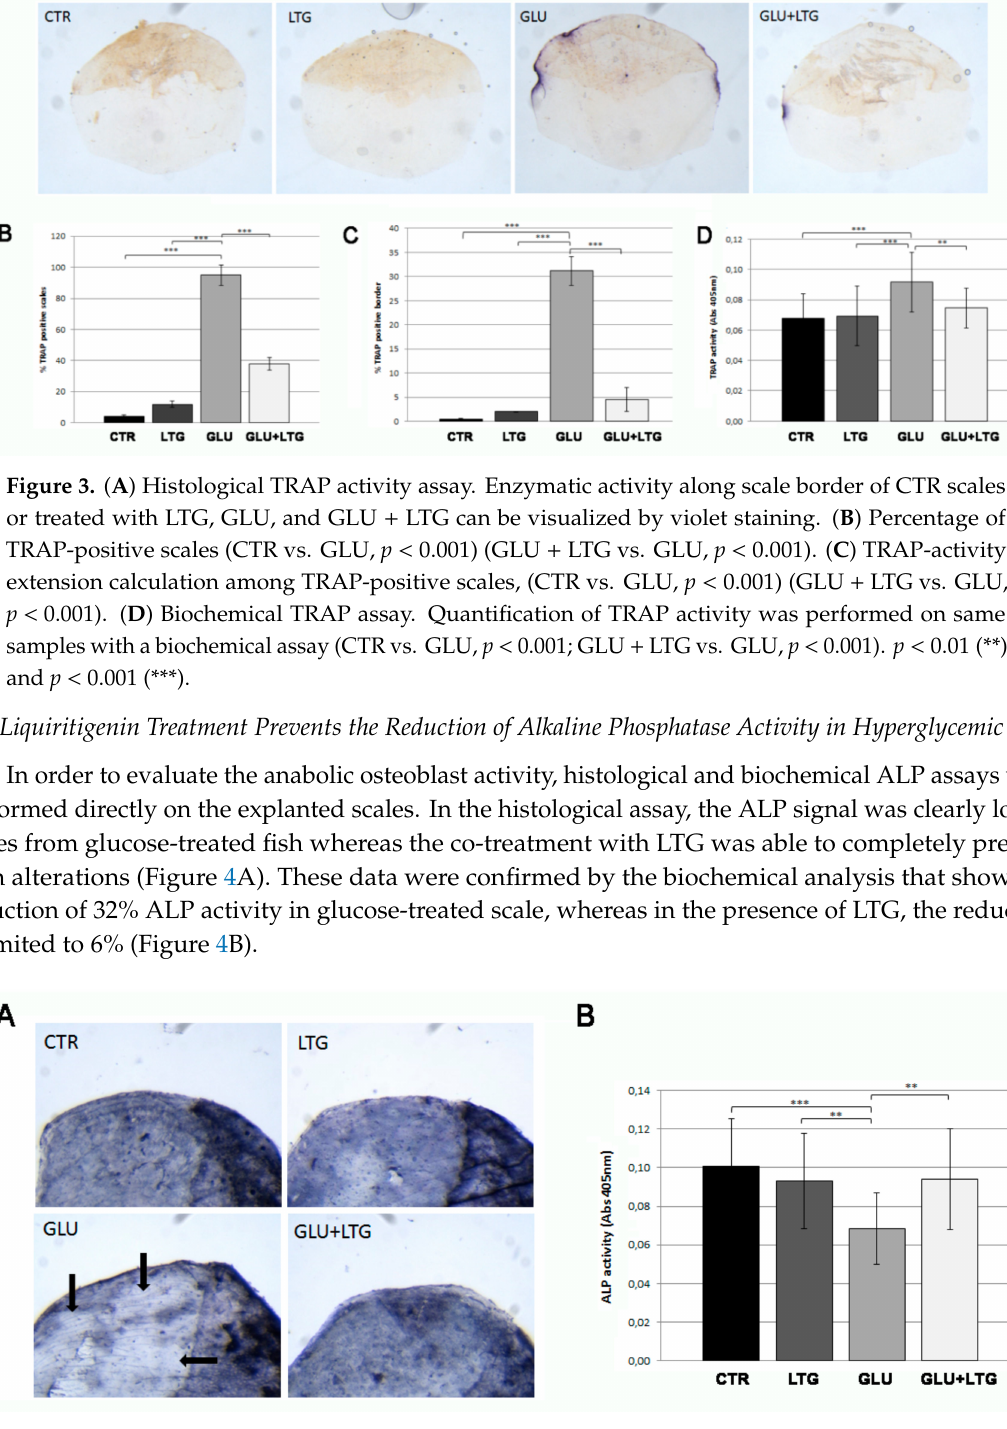
Figure 4. ( A ) Histological ALP activity assay. Enzymatic ALP activity of CTR scales or treated with LTG, GLU, and GLU + LTG can be visualized as blue staining. The areas of fish scale with a reduced ALP activity are evidenced by black arrows. ( B ) Biochemical ALP assay. Quantification of ALP activity was performed on same samples with a biochemical assay (CTR vs. GLU, p < 0.001) (GLU + LTG vs. GLU, p < 0.01). p < 0.01 (**) and p < 0.001